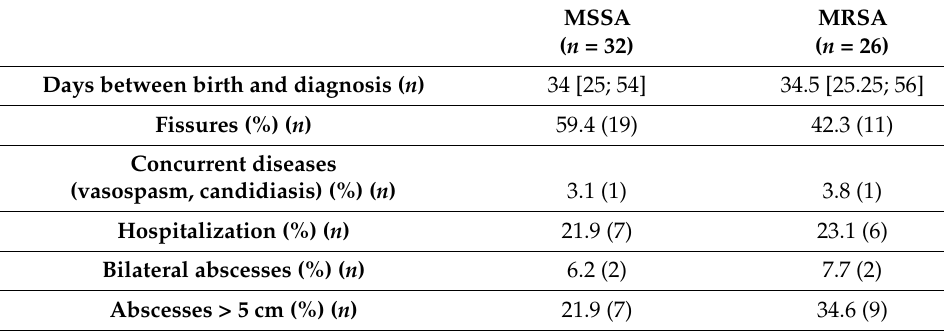
Table 6. Clinical features of patients with S. aureus